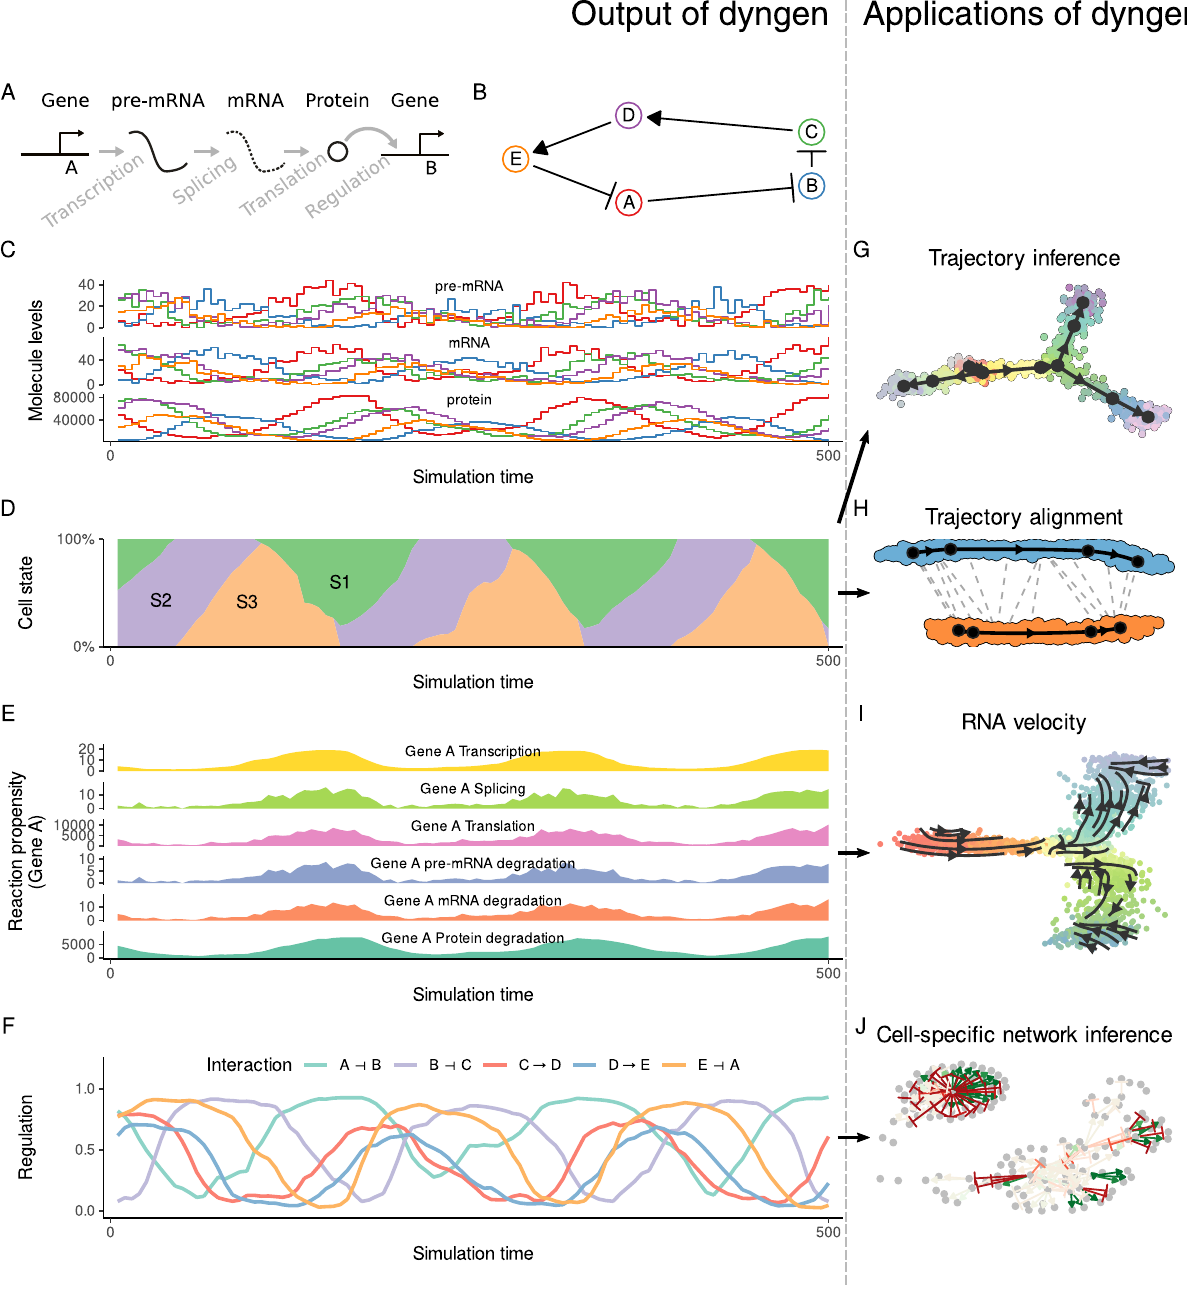
Fig. 1 Showcase of dyngen functionality. A Changes in abundance levels are driven strictly by gene regulatory reactions. B The input Gene Regulatory Network (GRN) is de fi ned such that it models a dynamic process of interest. C The reactions de fi ne how abundance levels of molecules change at any particular time point. D Firing many reactions can signi fi cantly alter the cellular state over time. E dyngen keeps track of the likelihood of a reaction fi ring during small intervals of time, called the propensity, as well as the actual number of fi rings. F Similarly, dyngen can also keep track of the regulatory activity of every interaction. G A benchmark of trajectory inference methods has already been performed using the cell state ground-truth 21 . H The cell state ground-truth enables evaluating trajectory alignment methods. I The reaction propensity ground-truth enables evaluating RNA velocity methods. J The cellwise regulatory network ground-truth enables evaluating cell-speci fi c gene regulatory network inference